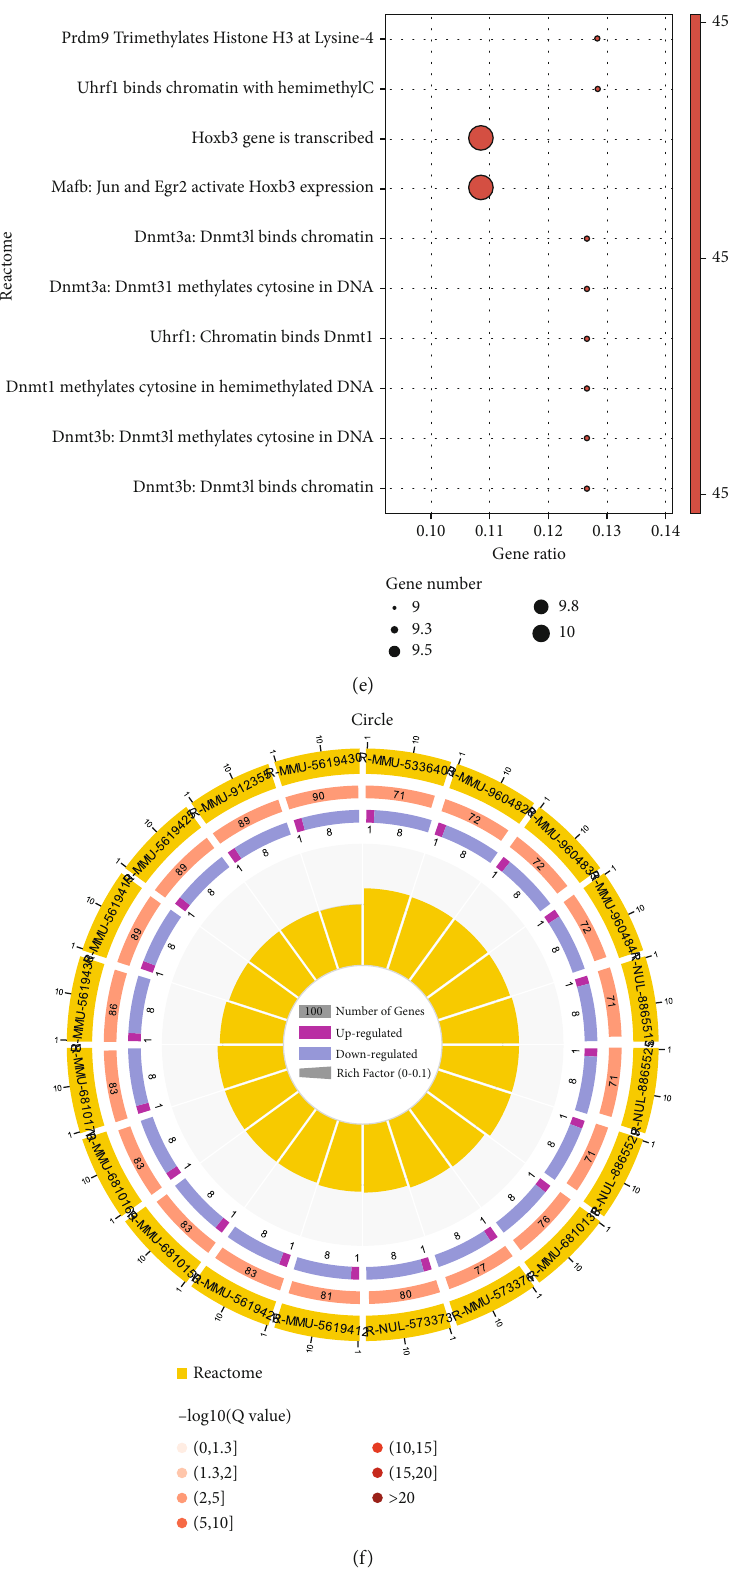
Figure 4: GO, KEGG, and Reactome analysis results of DEGs. (a) Bubble diagram and (b) circle diagram exhibited GO enrichment analysis results of the DEGs. (c) Bubble diagram and (d) circle diagram showed KEGG enrichment analysis results of the DEGs. (e) Bubble diagram and (f) circle diagram displayed Reactome pathway analysis results of the